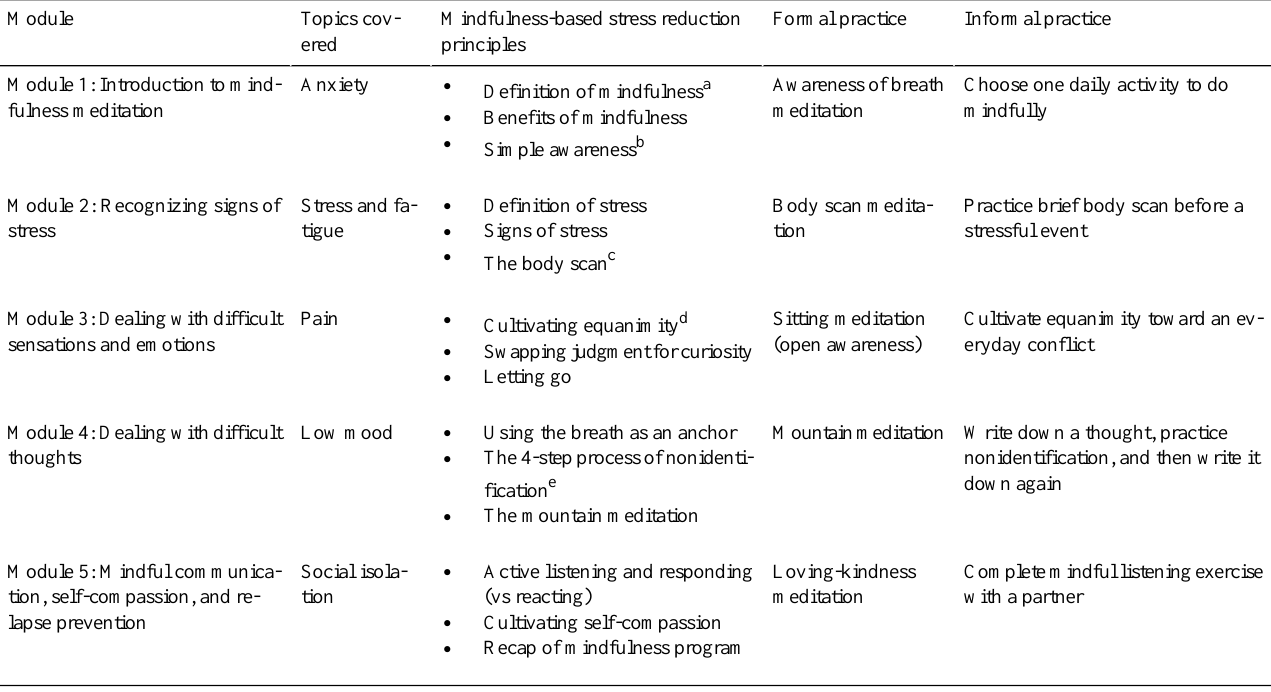
Table 1. Web-based mindfulness program